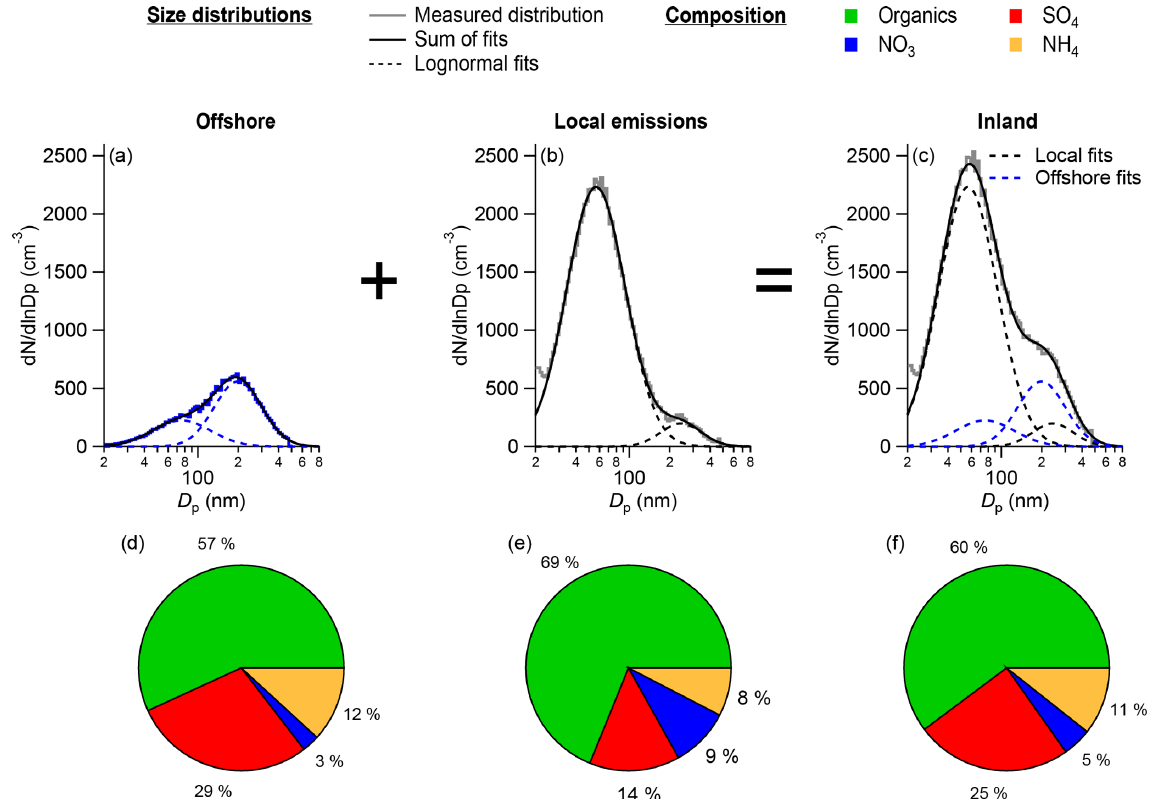
Figure 8. Aerosol size distributions (a–c) and accumulation mode composition measurements (d–f) made over SWA that were used as input into ACPIM. The averaged local emissions were calculated by subtracting the offshore transported aerosol from the inland regional aerosol.